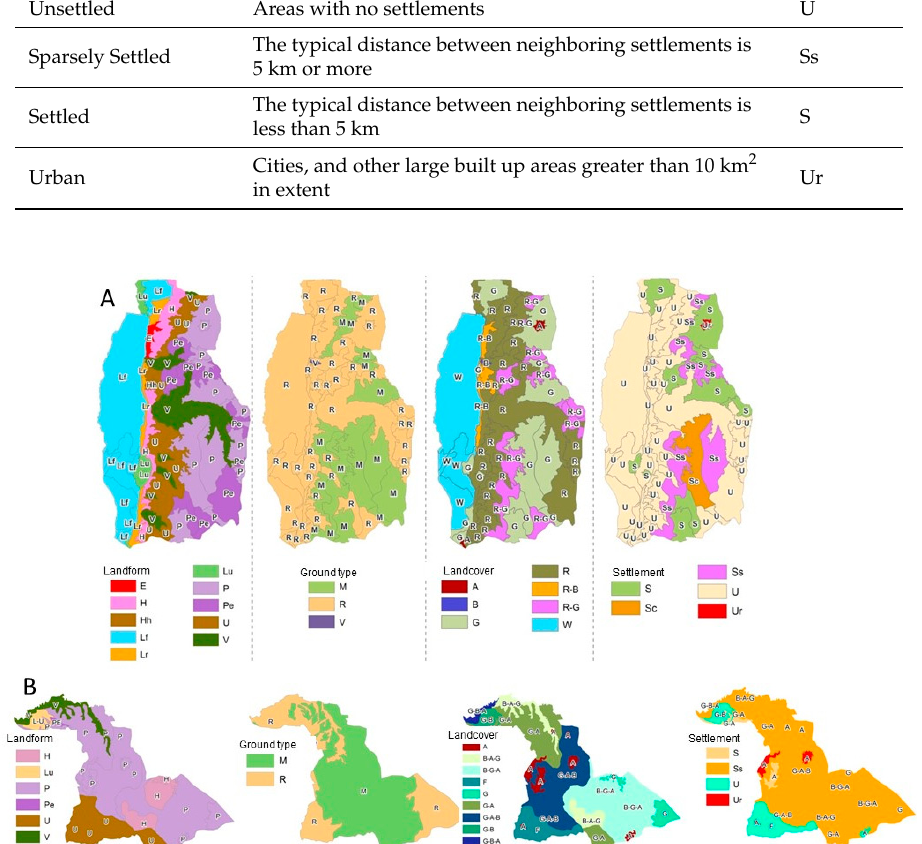
Figure 3. Land characterization based on landform, ground type, land cover, and settlement pattern. ( A ) is for the Wadi Mujib case study and ( B ) is for the Wadi Yarmouk case study. The meanings of letters are defined in the tables.